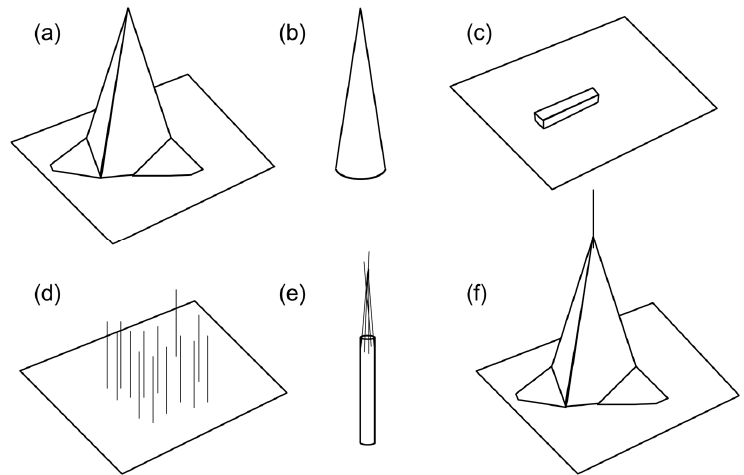
Figure 1. Nanotip geometry based on the fabrication methods: ( a ) conventional atomic force microscope (AFM) tips; ( b ) cone-shaped nanotip; ( c ) nanotip on a flat substrate; ( d ) nanotips grown on substrate; ( e ) nanotips fabricated by capillary action and an electric field; and ( f ) nanotip composed of an AFM tip attached with a nanowire or a nanotube. Panels ( a – c ) are fabricated by top down methods; panels ( d , e ) are fabricated by bottom-up methods; and panel ( f ) is fabricated by a hybrid method combining bottom-up and top-down methods.